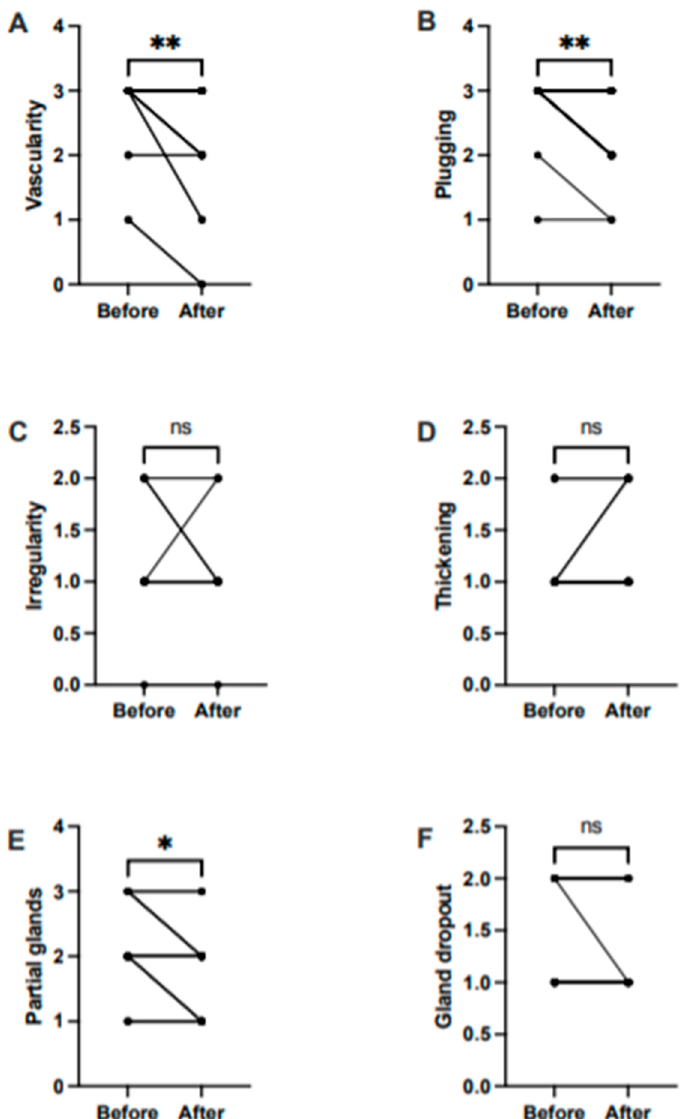
Figure 2. Treatment effect before and after treatments on components of the MGD score. ( A ) Abnormal lid margin findings of vascularity; ( B ) plugging of gland orifices; ( C ) lid margin irregularity; ( D ) lid margin thickening; ( E ) partial glands; and ( F ) gland dropout. Lines represent outcomes before and after treatment. * p < 0.05; ** p < 0.01; ns, non ‐ significant.